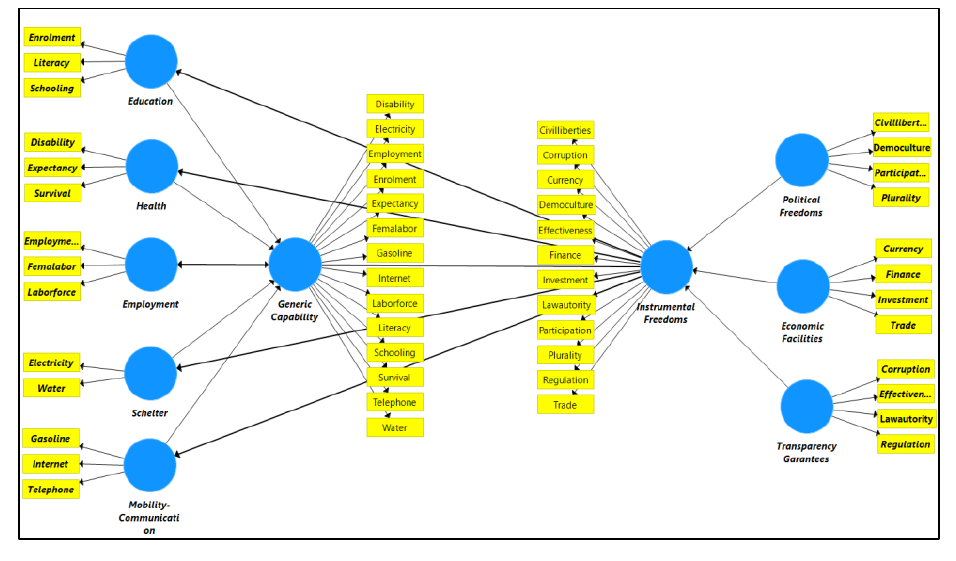
Figure 1: Conceptual